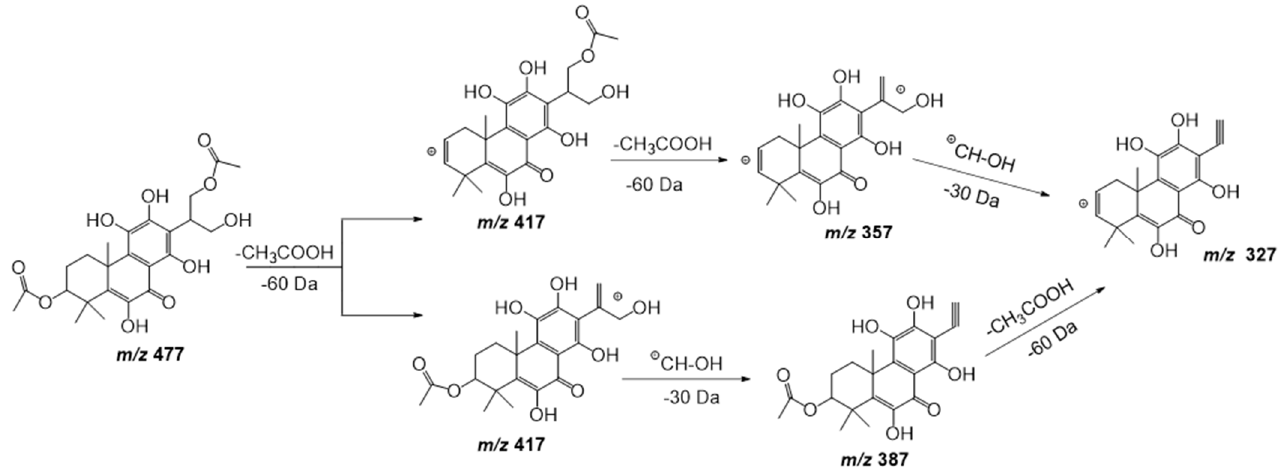
Figure 7. Fragmentation pathway (ESI negative mode) proposed for compound 17 : 6,11,12,14,16- pentahydroxy-3,17diacetyl-5,8,11,13-tetraene-7-one.